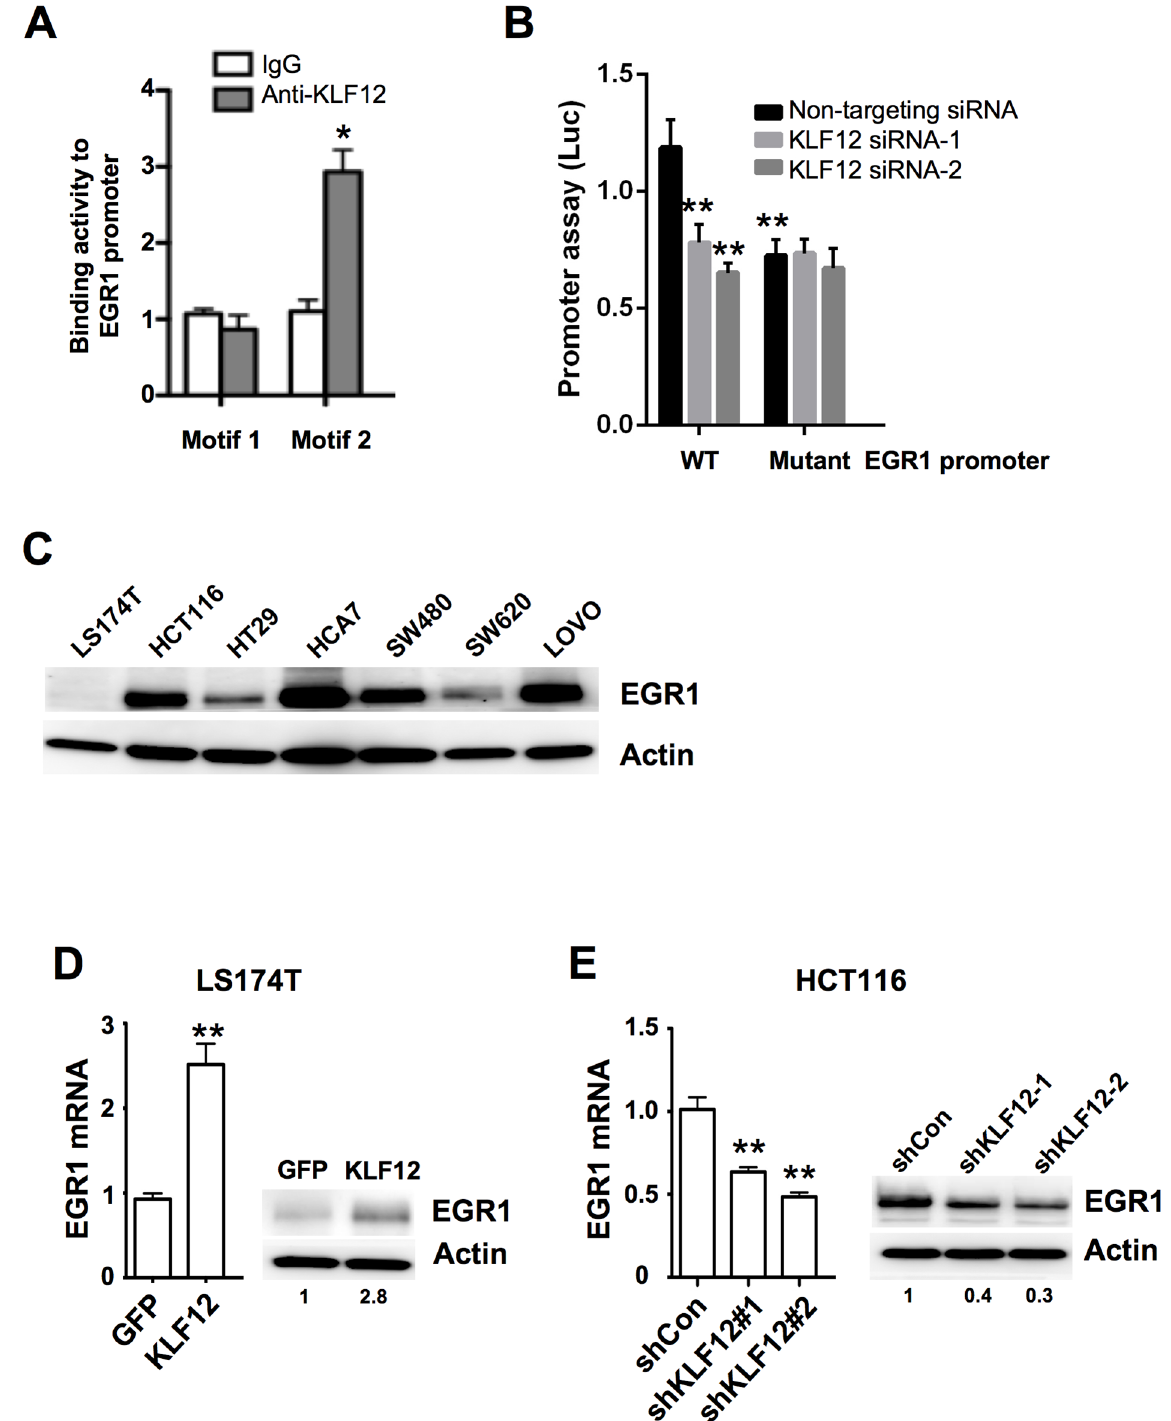
Fig 2. EGR1 is a direct target of KLF12 mediating cell viability. (A) Chromatin immunoprecipitation (ChIP) assay showed binding of KLF12 to motif 2 of the EGR1 promoter, but not to motif 1 in LS-174T cells. Immunoprecipitation with IgG antibody was used as a control. (B) Transient co-transfection of cells was performed with EGR1 promoter wild type (WT), or mutant luciferase reporter plasmids with renilla luciferase control plasmids and non-targeting or KLF12 siRNA. The luciferase activity was determined. (C) EGR1 protein levels in CRC cell lines. Actin served as a loading control. (D) EGR1 mRNA (left) and protein (right) levels in LS174T cells stably transfected with either GFP or KLF12. Actin served as a loading control. E. EGR1 mRNA (left) and protein (right) levels in